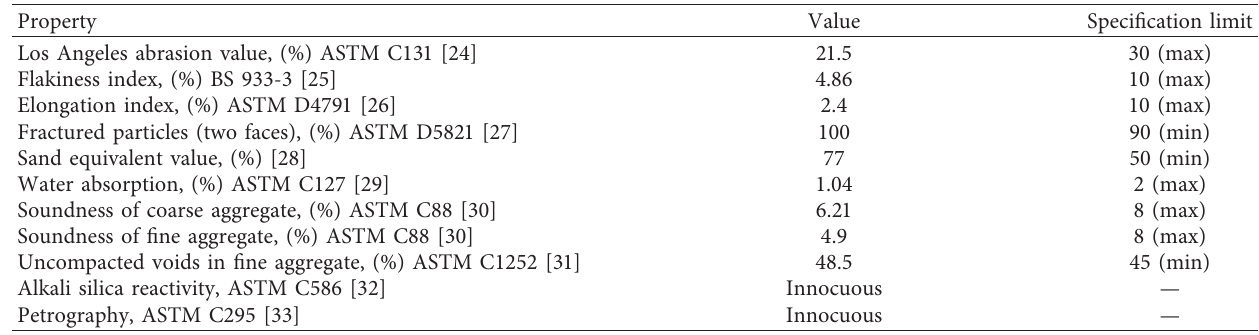
Table 4: Properties of Margalla